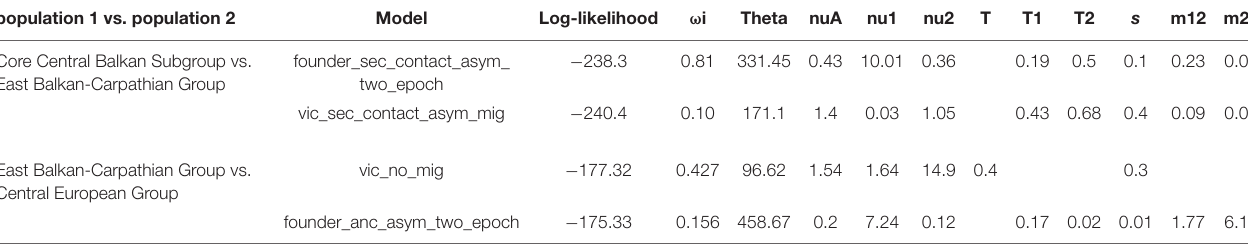
TABLE 2 | Two best demographic models and unscaled parameter values for pairwise population comparisons. population 1 vs. population 2